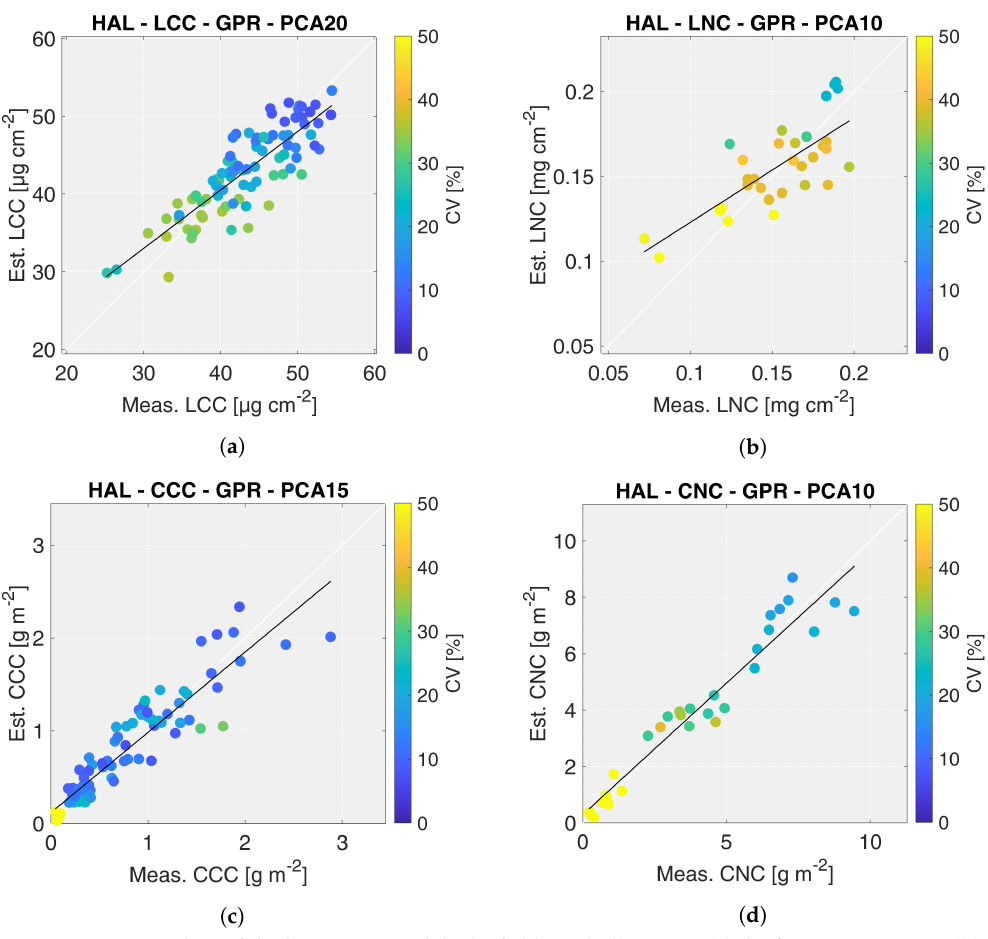
Figure 4. Scatter plots of the best HAL models: leaf chlorophyll content ( a ), leaf nitrogen content ( b ), canopy chlorophyll content ( c ), canopy nitrogen content ( d ). The colors of points represent the coefficient of variation (CV) estimated by the GPR